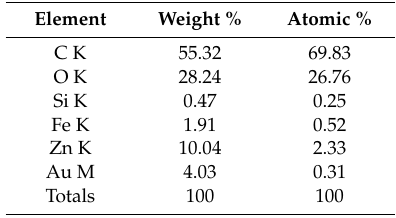
Table 1. Elemental analysis of zinc oxide coated silk hydrogel dressing.